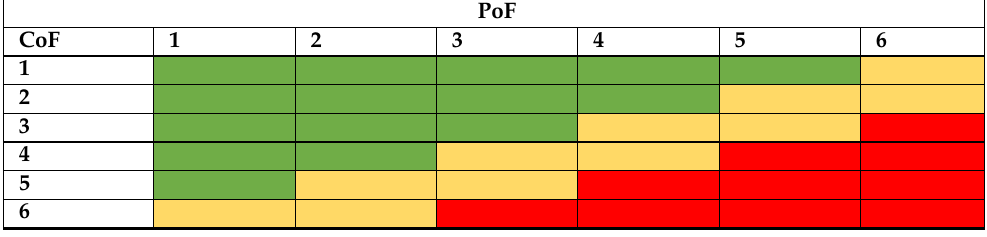
Table 1. An example of a risk matrix that is applied in the offshore industry. CoF